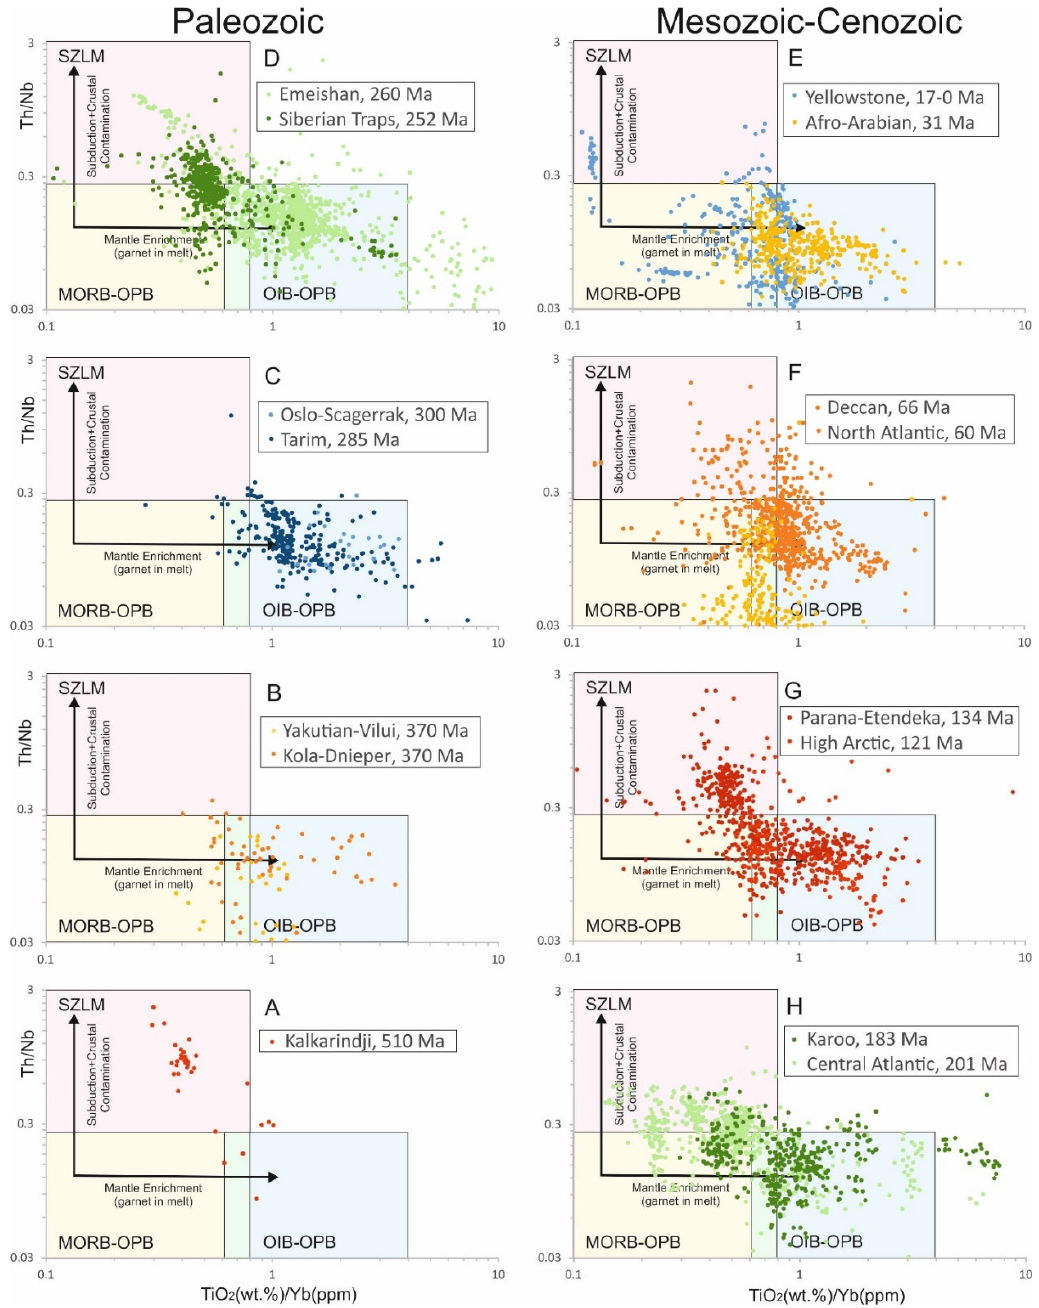
Figure 3. Th/Nb vs. TiO 2 /Yb in mafic rocks (SiO 2 = 41–52 wt.%) from the selected LIPs on the LIP printing diagram with a subduction ‐ modified lithospheric mantle (SZLM) array and a ‘plume’ array [16,17]. MORB, mid ‐ oceanic ridge basalt; OIB, oceanic island basalt; OPB, oceanic plateau basalt. Data sources are cited in Section 2. ( A ) Kalkarindji; ( B ) Yakutian ‐ Vilui and Kola ‐ Dnieper; ( C ) Scagerrak and Tarim; ( D ) Emeishan and Siberian Trips; ( E ) Yellowstone and Afro ‐ Arabian; ( F ) Geccan and North Atlantic; ( G ) Parana ‐ Etendeka and High Arctic; ( H ) Karoo and Central Altantic.